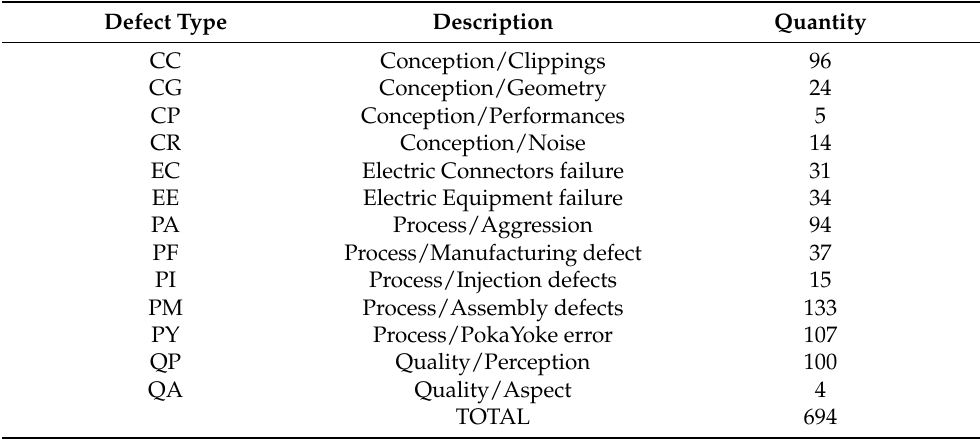
Table 8. Defect type description of quality actions database.